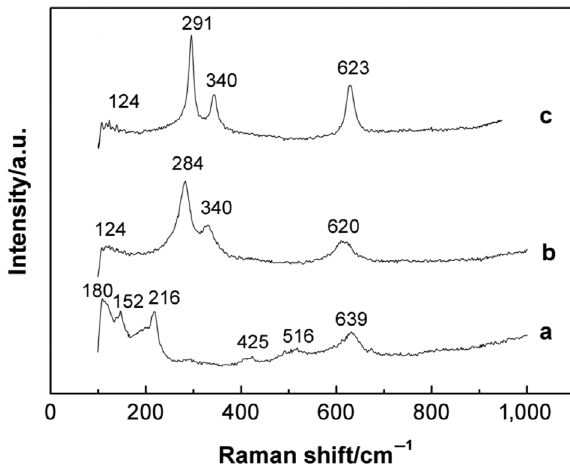
Figure 9: The Raman spectra of CuCl residue before and after opti- mum experimental conditions: (a) samples before microwave roast- ing, (b) samples after microwave roasting and (c) pure copper